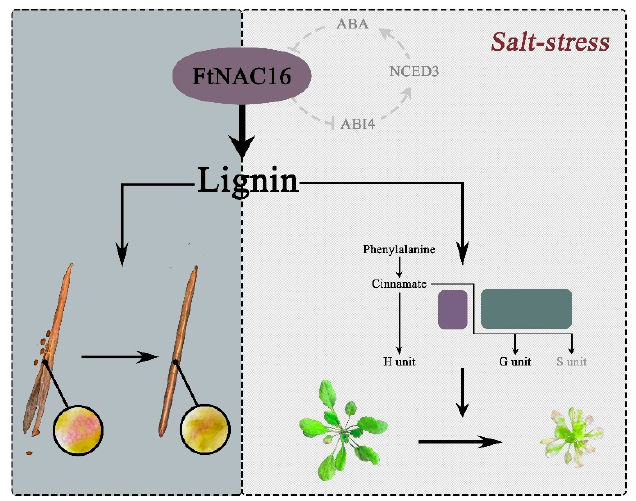
Figure 9. Functional model of FtNAC16. FtNAC16 not only regulates pod cracking through the lignin pathway, but also affects salt stress tolerance. The gray background represents the effect of FtNAC16 on the cracking of A. thaliana plant pods through the lignin pathway, the beige background shows the effect of FtNAC16 on the tolerance of salt stress, and the line ring depicts the hypothesis regarding FtNAC16 and ABA pathways. Short lines indicate inhibition; dashed lines indicate possible